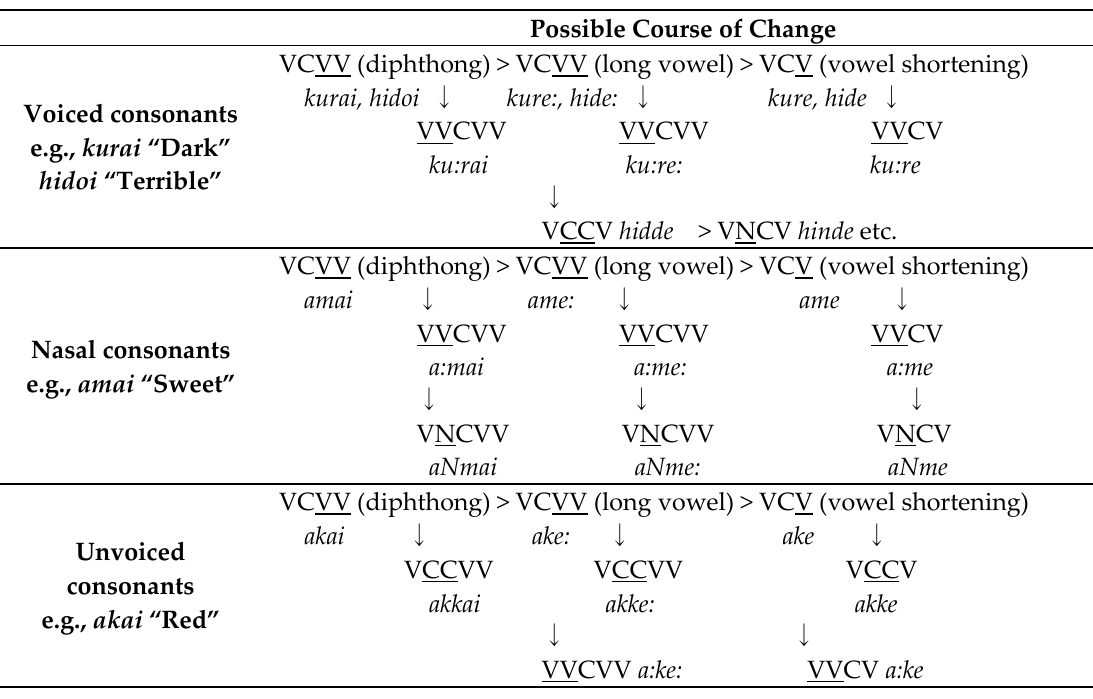
Table 3. The finalized hypothesis on the change of phonological types of adjectives in Niigata.